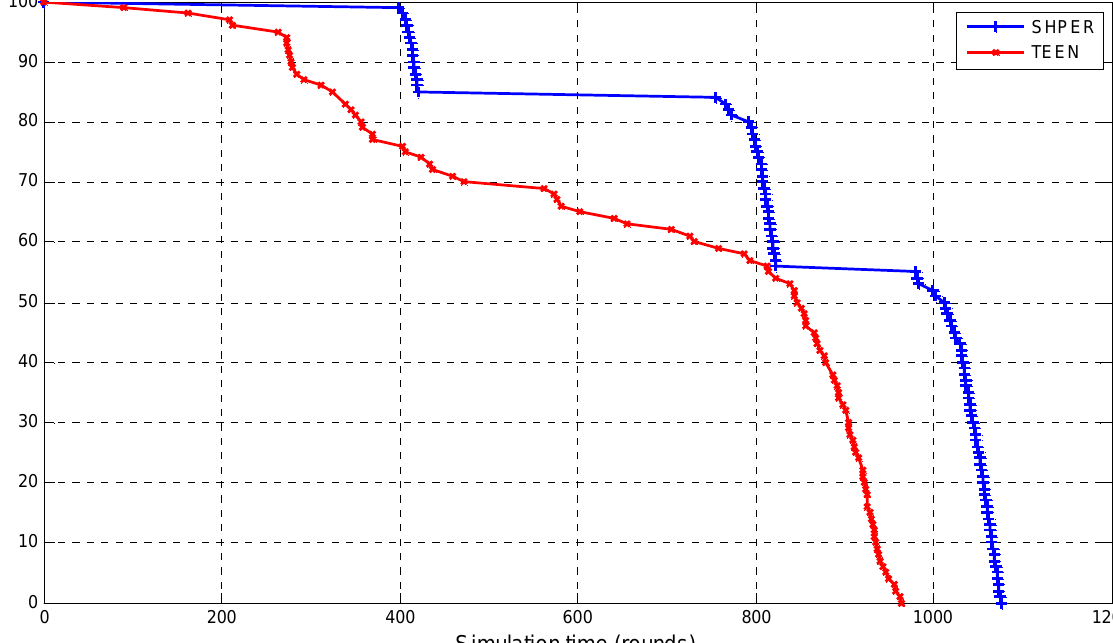
Figure 9. Percentage of average decrease of energy consumption in SHPER opposed to TEEN over the distance of the base station from the WSN field [ Er